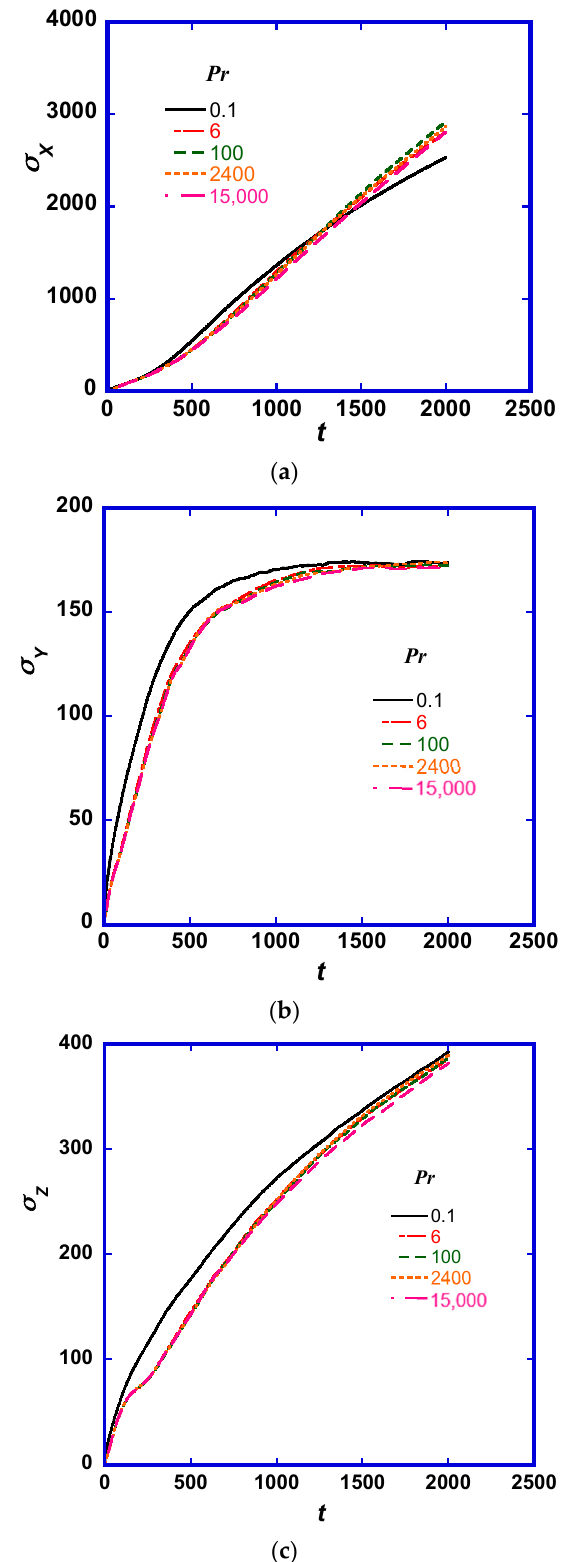
Figure 2. Standard deviation of the scalar marker location in the ( a ) streamwise direction, x ; ( b ) wall normal direction, y ; and ( c ) the spanwise direction z .